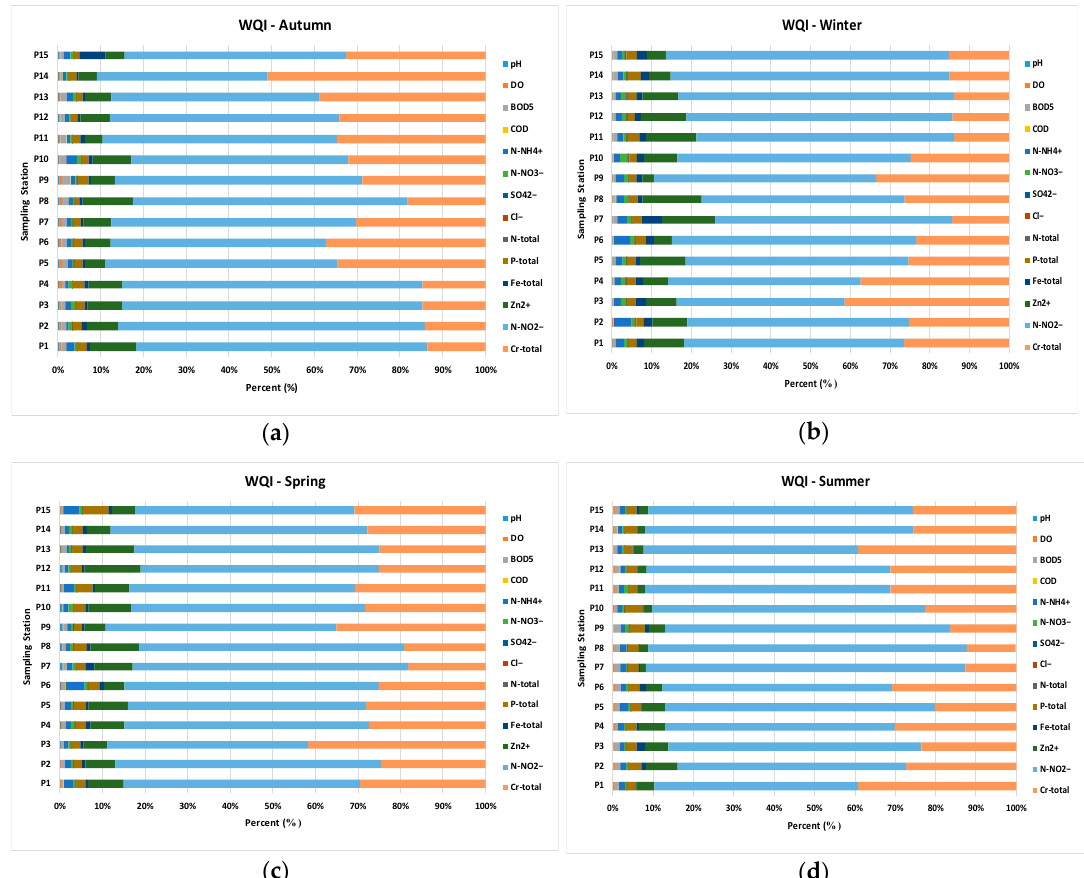
Figure 5. The weight of each parameter to the WQI values recorded in autumn ( a ), winter ( b ), spring ( c ) and summer ( d ).